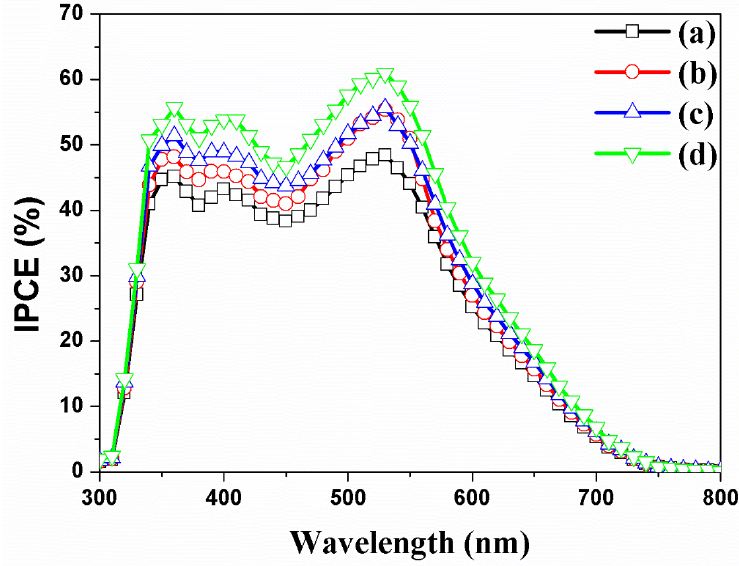
Figure 8. Incident photon-to-current conversion efficiency (IPCE) of DSSC based on the f-TNTAs (a) without both Au NPs and a scattering layer, (b) with Au NPs, (c) with a scattering layer, and (d) with Au NPs and a scattering layer.